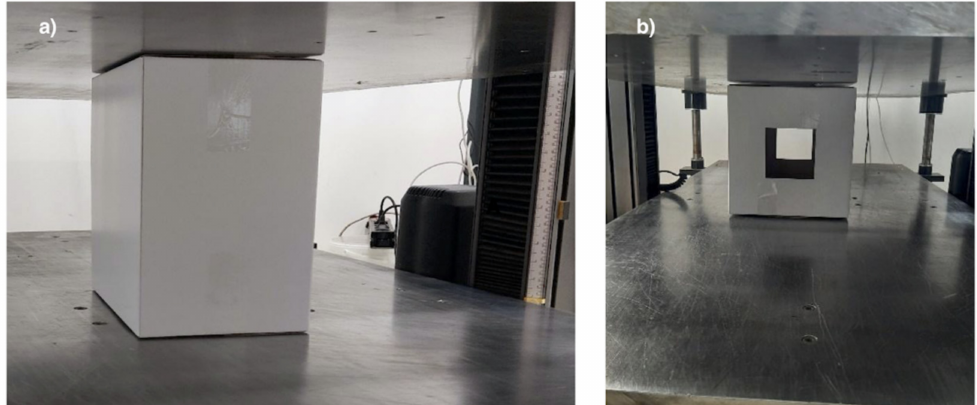
Figure 5. Setup of the box compression tests (BCTs): ( a ) control sample and ( b ) cutout sample. Ten samples were tested for each package design with two hundred and fifty samples in total. The compression force and deformation were recorded. A typical BCT force– deformation diagram is shown in Figure 6.